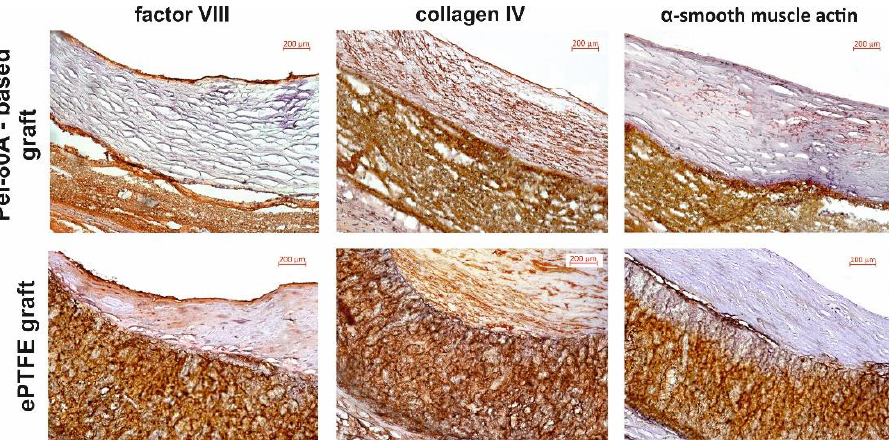
Figure 7. Immunohistochemical staining of VGs at 24 weeks after implantation in rats (lumen of graft appears in the top right). Scale bar is 200 μm. graft appears in the top right). Scale bar is 200 µ